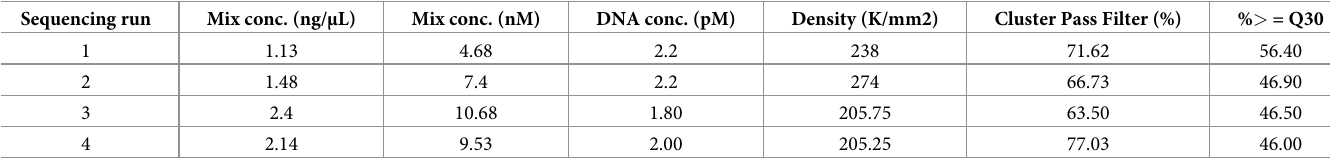
Table 1. Poly(A)-seq sequencing quality scores from NextSeq 500. Sequencing